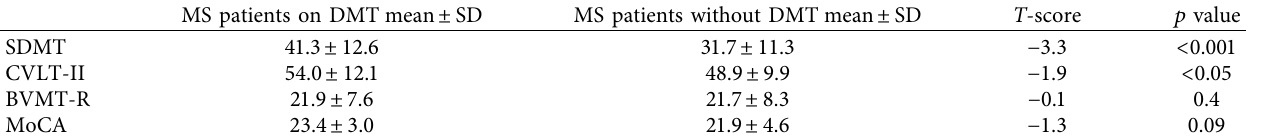
Table 4: Comparison of cognitive test results between MS subtype